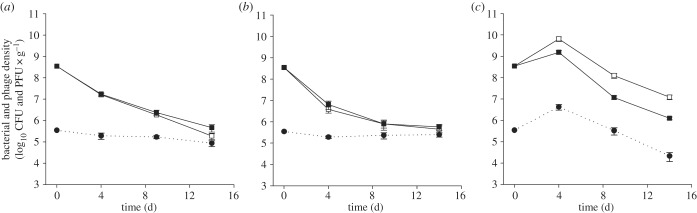
Population dynamics of bacteria and phage under different mixing regimes. Mean densities (±s.e.m.) of P. fluorescens SBW25 (solid lines; CFUs g−1 soil) and phage SBW25φ2 (dotted lines; PFUs g−1 soil) populations under no (a), daily (b) and soil–water (c) mixing treatments. Bacteria population densities were determined in the absence (unfilled squares) and presence (filled squares) of phages.